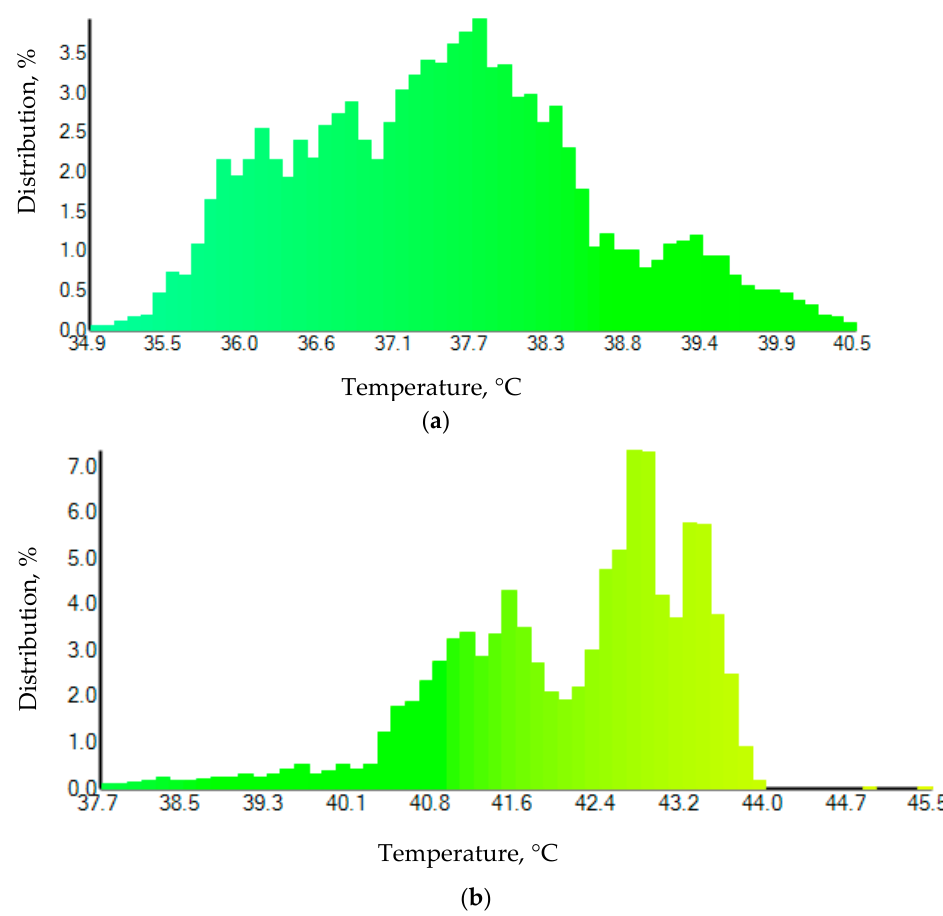
Figure 7. Histogram for the temperature distribution of ( a ) cooled panel ( b ) referenced panel.